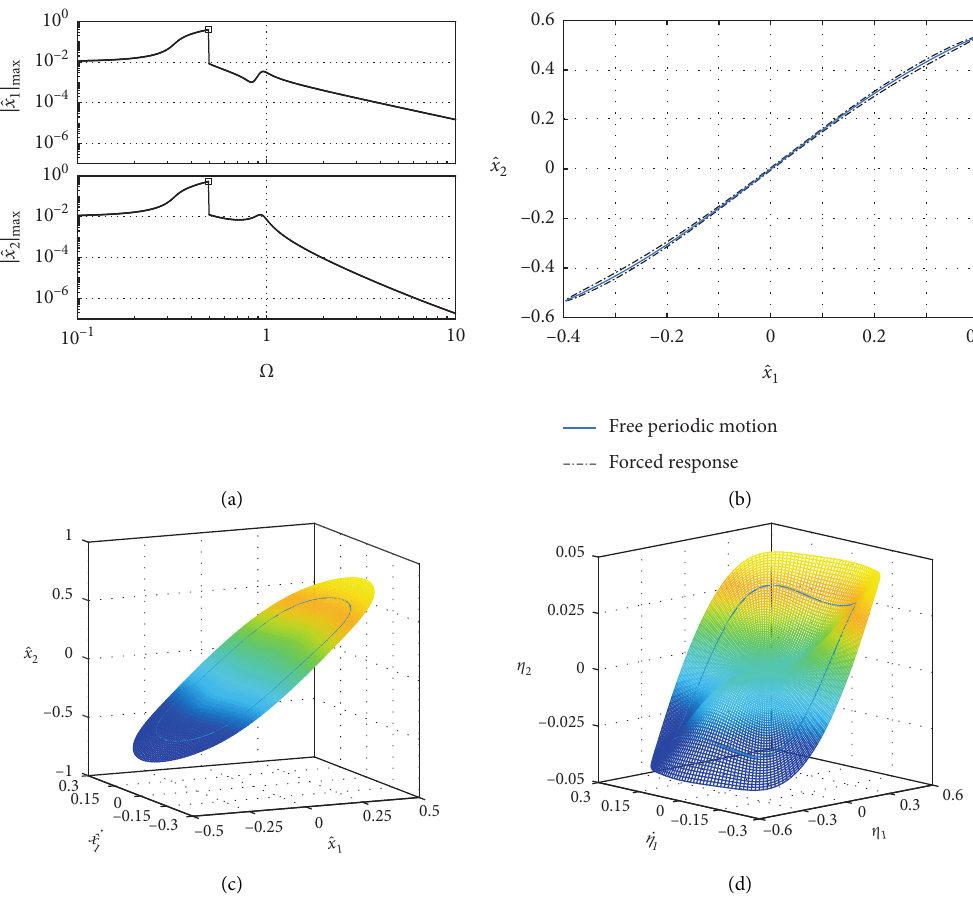
Figure 3: The forced responses of a type III two-stage isolator in primary resonance, for 􏽢 k � 1 . 0 and F � 0 . 0015, and the corresponding h 1 free periodic motion of NNM invariant manifold for the underlying conservative system. The other parameters of the system are the same as in Figure 2. (a) Displacement amplitude-frequency responses for the payload and the responses for the lower stage in a type III two-stage isolator. (b) The representative forced response in primary resonance of the system is shown in black dot-dashed line, which corresponds to the square points on the curves in (a). The free periodic motion of the underlying conservative system is shown in blue solid line. The corresponding forced orbit occurs in the neighbourhood of this free motion. (c) The approximation of the corresponding NNM invariant ( 􏽢 x , _ 􏽢 x ) and the free periodic motion from (b), shown as blue solid curve. (d) The approximate manifold for the displacement constraint 􏽢 x 2 1 1 ( η , _ η ) is the projection of 􏽢 x ( 􏽢 x , _ 􏽢 x ) onto the phase space of generalized modal coordinates. The free periodic NNM invariant manifold η 2 1 1 2 1 1 motion in (c) is also projected on this phase space as blue solid